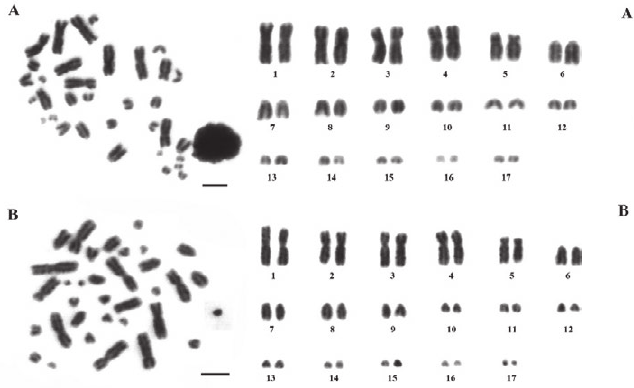
Figure 1. Metaphase chromosome plates and karyotypes of G. nuta- phandi (A) male (B) female by conventional technique. Scale Bars = 10 µm.